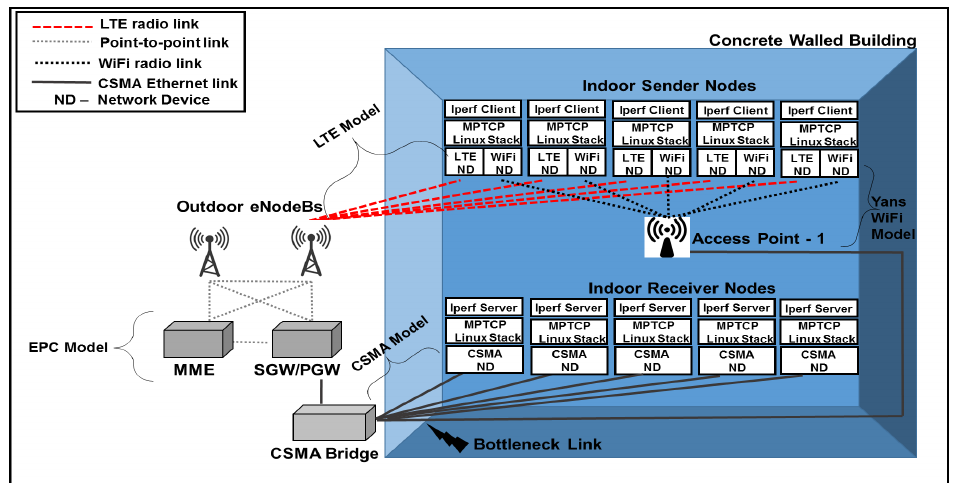
Figure 4. Simulation Setup 2.